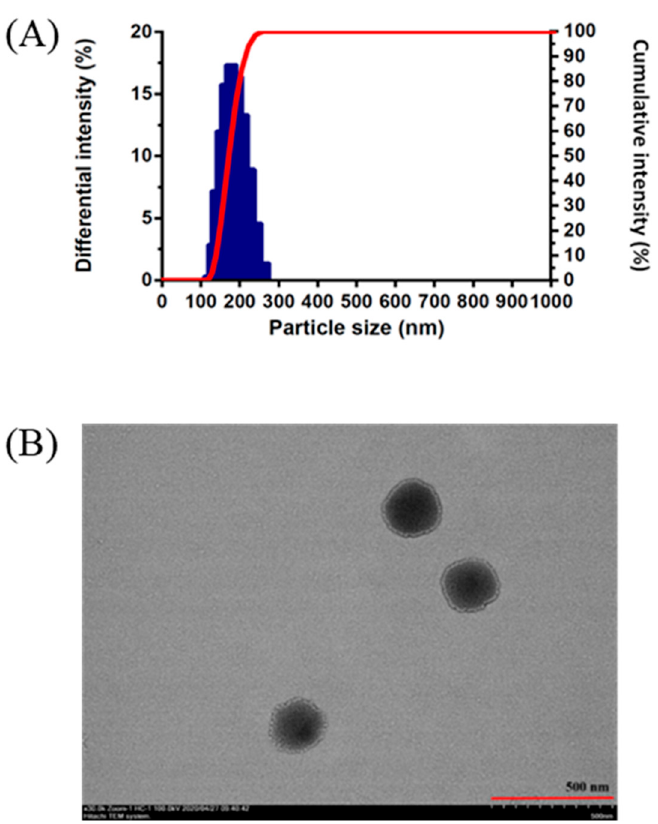
Figure 4. The particle size measured by ( A ) DLS and ( B ) transmission electron microscopy image of FST–NP optimized formulation.